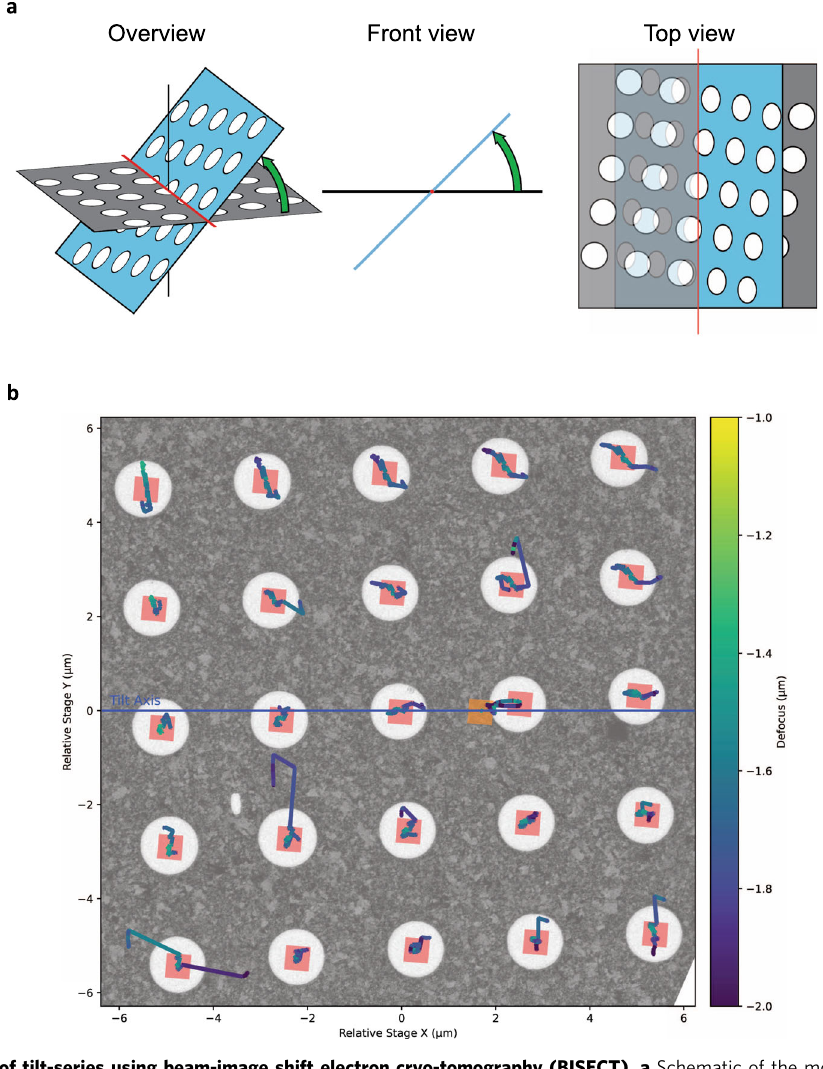
Fig. 1 Parallel acquisition of tilt-series using beam-image shift electron cryo-tomography (BISECT). a Schematic of the movement of ROIs (white circles) from the initial position (gray) and after stage tilting (blue). b Evolution of the targeting and defocus over a 5 × 5-hole area. The initial fi eld of view of each area is shown as red squares. The high-magni fi cation tracking area is shown as an orange square. Lines show the movement of the targeting obtained from cross-correlation alignment (scaled by 5 for visualization) and are color coded according to the estimated defocus for each image (large movements are attributed to errors in the cross-correlation at high-tilt and are not re fl ective of the actual motion of the sample). To allow for errors and discrepancies in the targeting of each hole, every BIS area is treated individually and gets its own Z-height fi t. This approach makes our routines more robust to irregular specimens that strongly deviate from an ideal plane such as the bending observed in samples with thicker